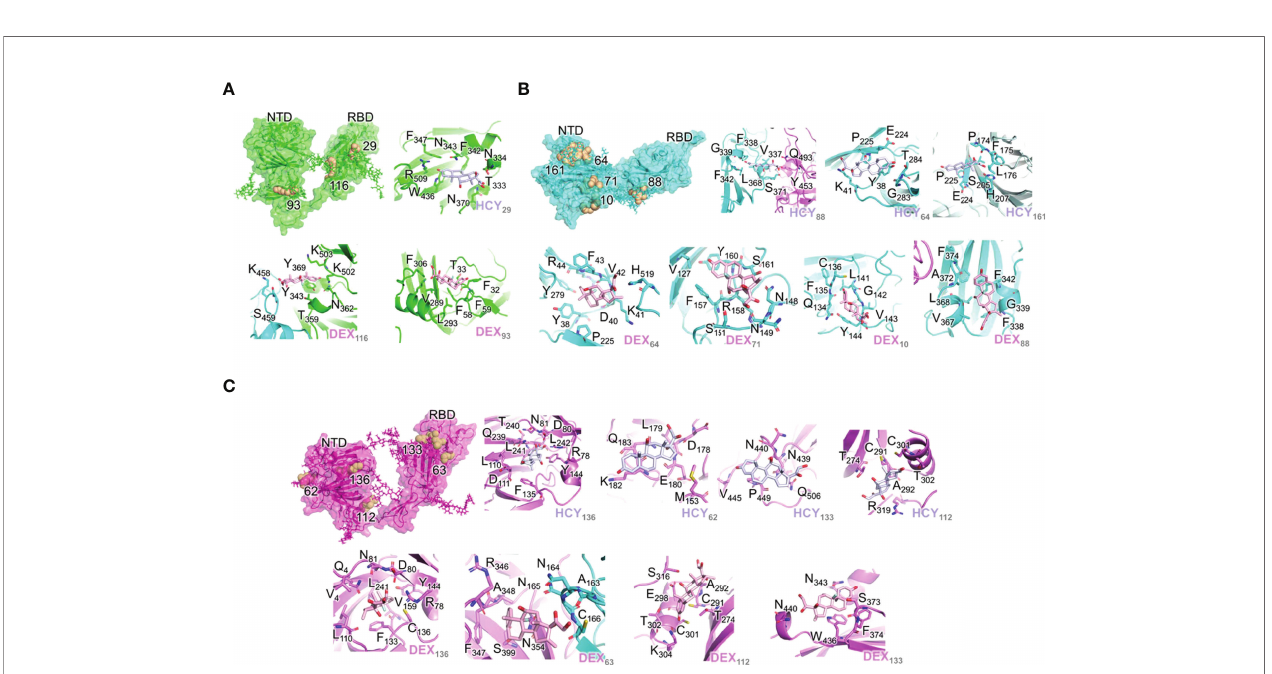
structural dynamics and plasticity of the individual spike monomers as a part of spike S1 trimer ( Supplementary Figure 3 ). As expected, pockets were found between NTD of one monomer and RBD of a second monomer, and also between RBDs of different monomers ( Table 4 ; Figure 2 ). As the NTDs of